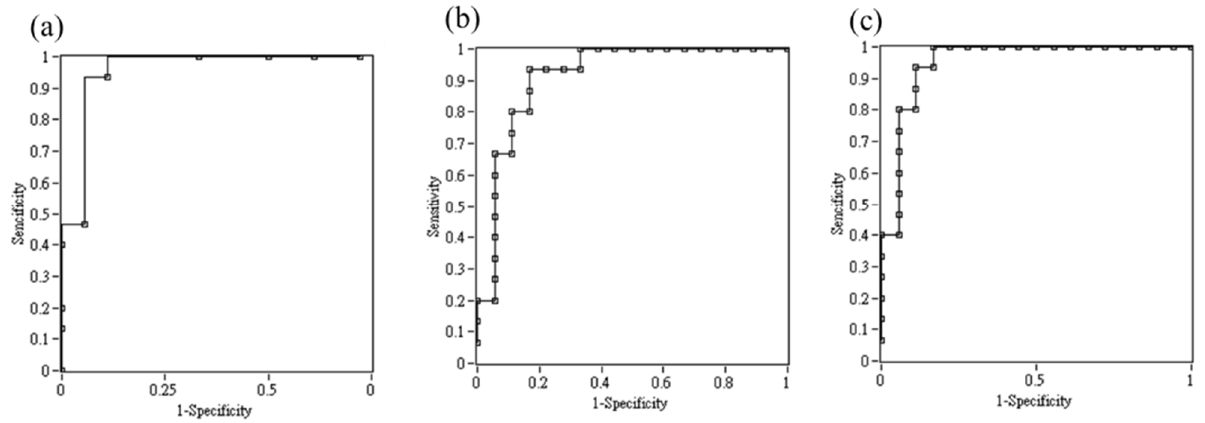
Figure 7. ROC curve of ( a ) pulse rate; ( b ) CDF(E(19)) of iPR; ( c ) logistic model of pulse rate and CDF(E(19)) of iPR.